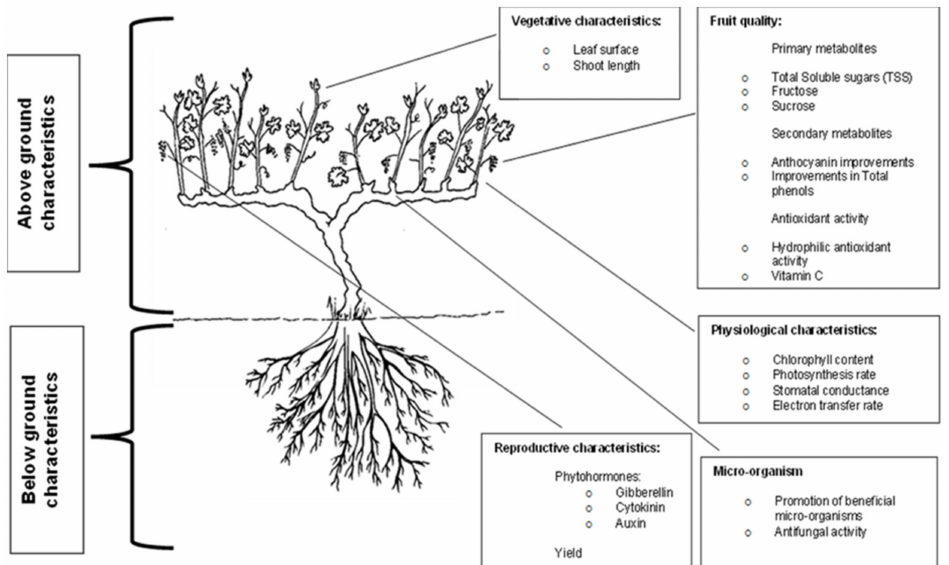
Figure 3. Benefits associated with the use of an Ascophyllum nodosum based seaweed extract biostimu- lants adapted from